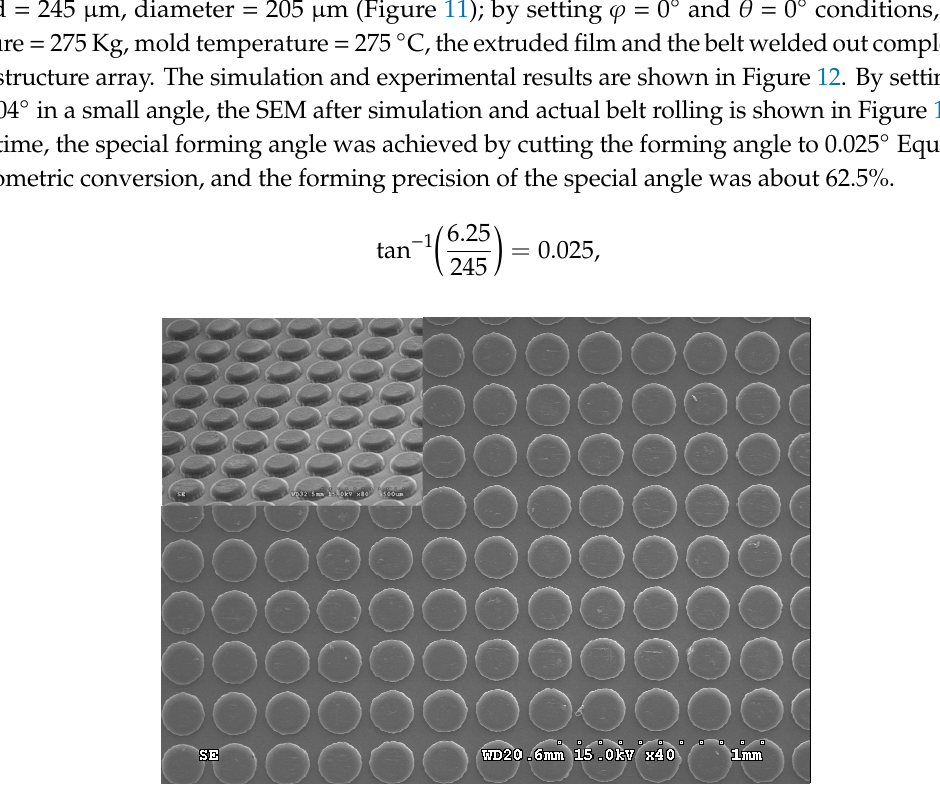
Figure 11. Scanning electron microscope (SEM) diagram of belt microstructure array.